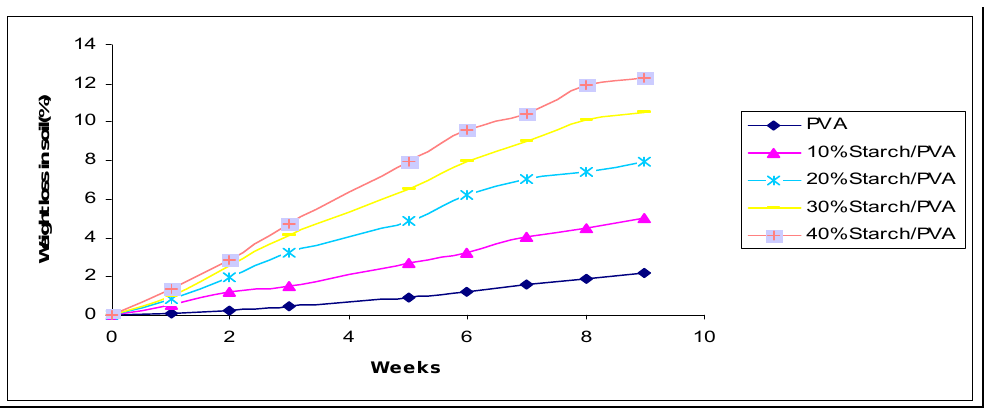
Fig. 15: The weight loss with the soil burial time at 13cm depth for the of PVA, and Starch/PVA at different ratio.